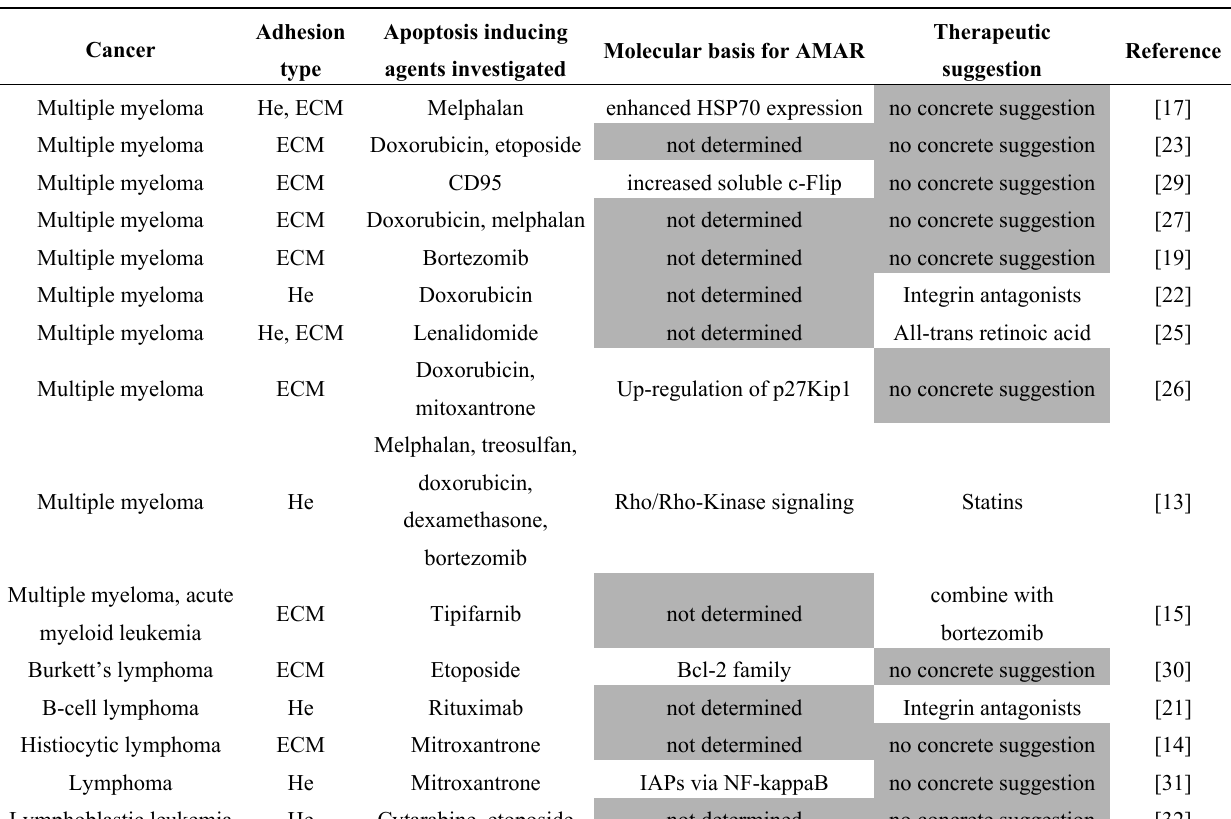
Table 1. AMAR in different malignancies. Instances of AMAR described in the literature, sorted by cancer cell type investigated. Of note, the repeated identification of the PI3K/Akt signaling network as AMAR mediator (see also Section II and Figure 3). Of